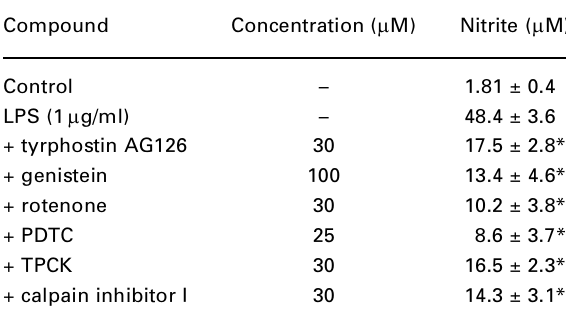
Data are expressed as mean±S.E.M. from triplicate determinations (well) from three separate experimental days ( n =9). * P <0.05 represents significant difference when compared to